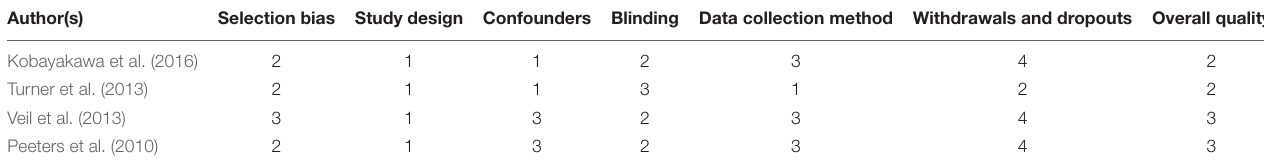
TABLE 2 | Quality assessment of quantitative studies according to the Quality Assessment Tool for Quantitative Studies, recommended by